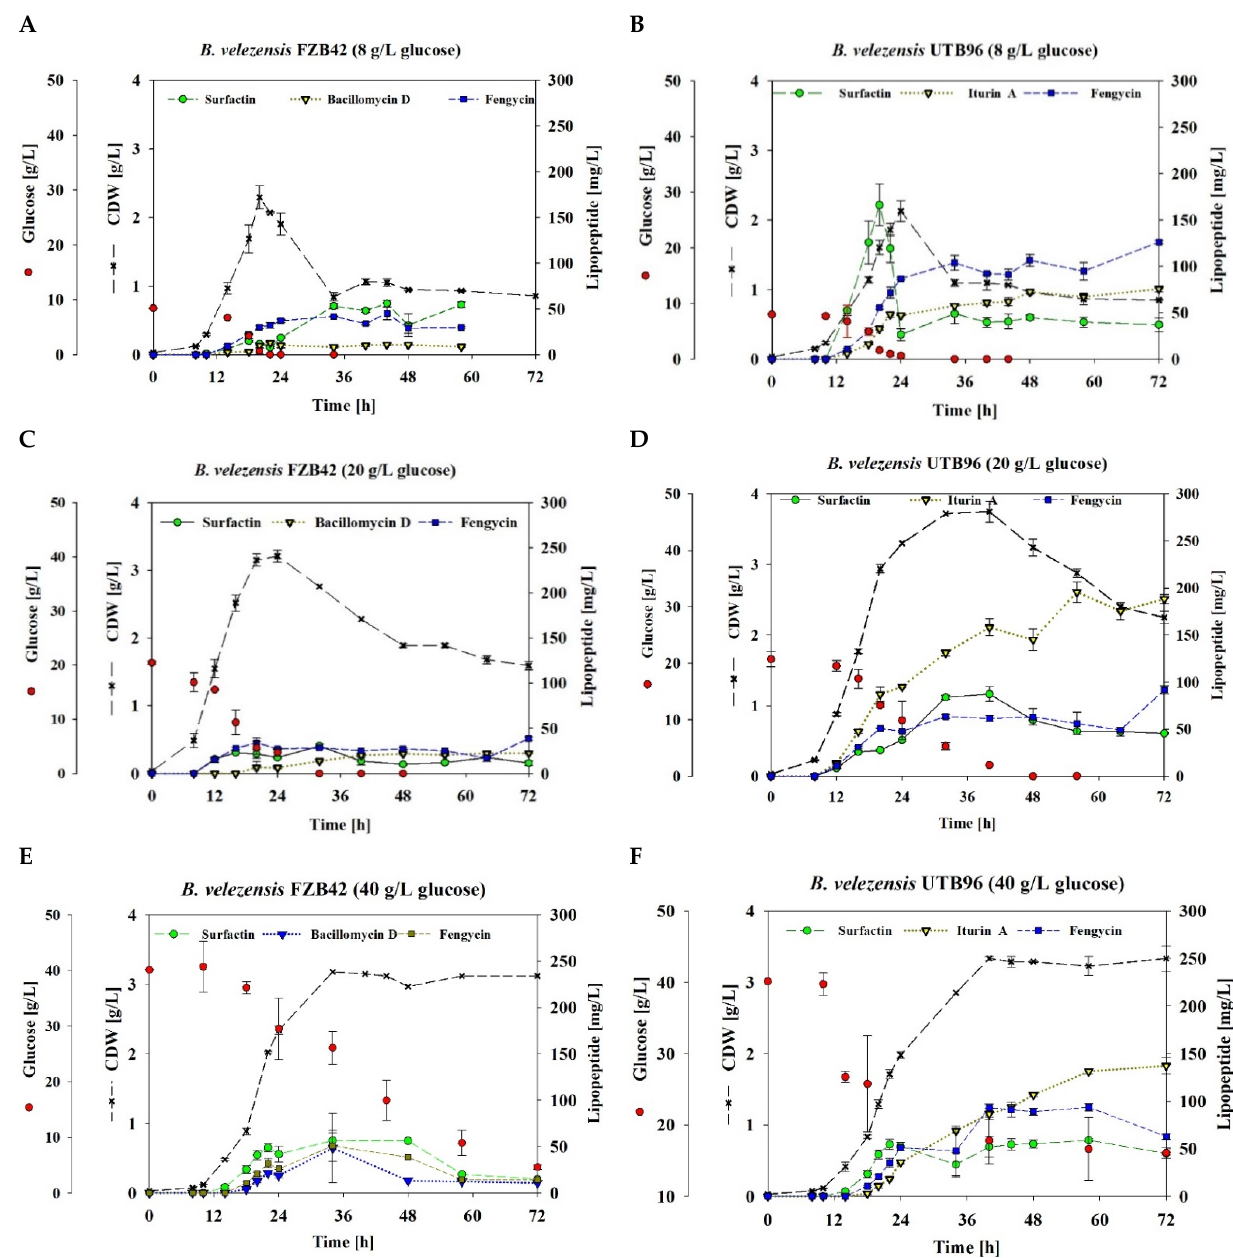
Figure 3. Overview of the time course of lipopeptide production by B. velezensis FZB42 and UTB96. The shake flask cultivations were conducted as biological triplicates in mineral salt medium containing different glucose concentration of 8 g/L ( A , B ), 20 g/L ( C , D ) and 40 g/L ( E , F ) at 30 ◦ C, 120 rpm and initial pH of 7.